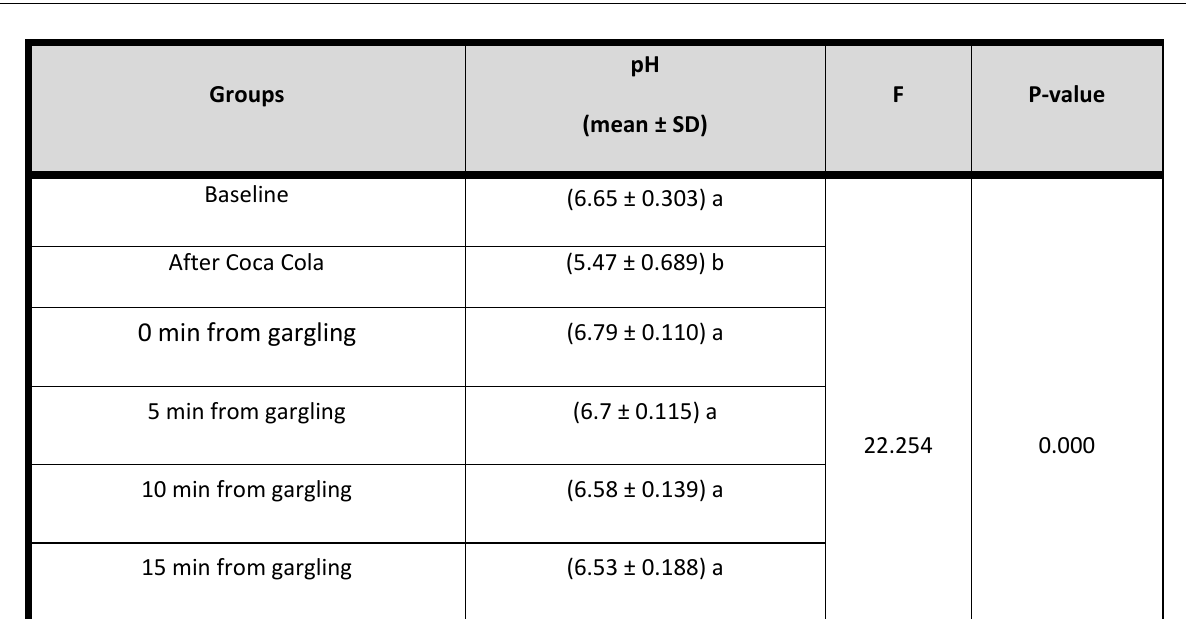
p ≤ Table 2. One way ANOVA for salivary pH after Herbal Mouthwash